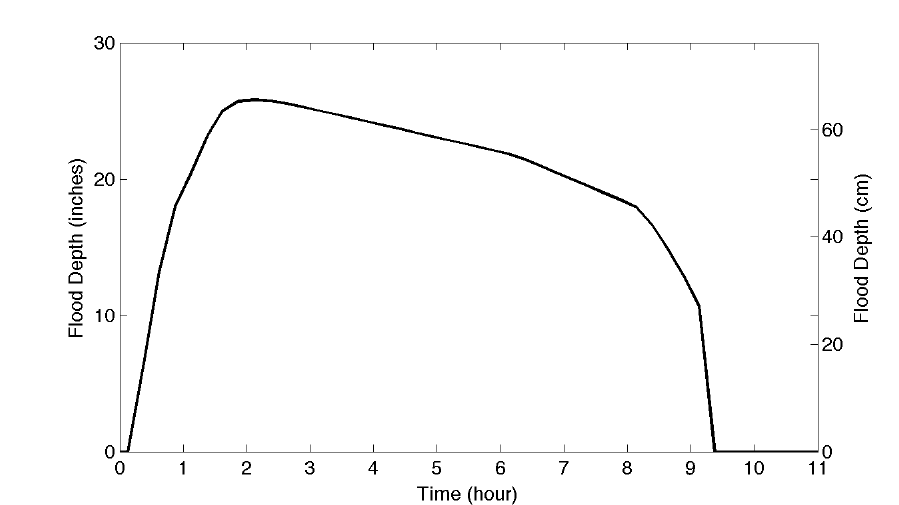
Figure 11. Flood depth variation over time in the Blacklot